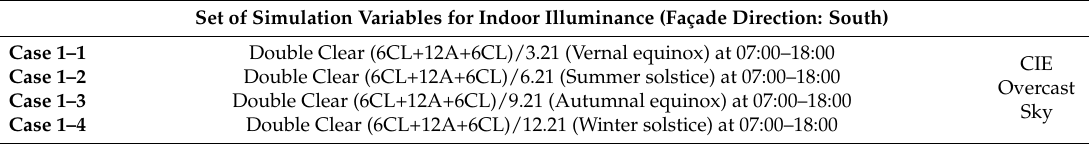
Table 5. Set of simulation variables for indoor illuminance.